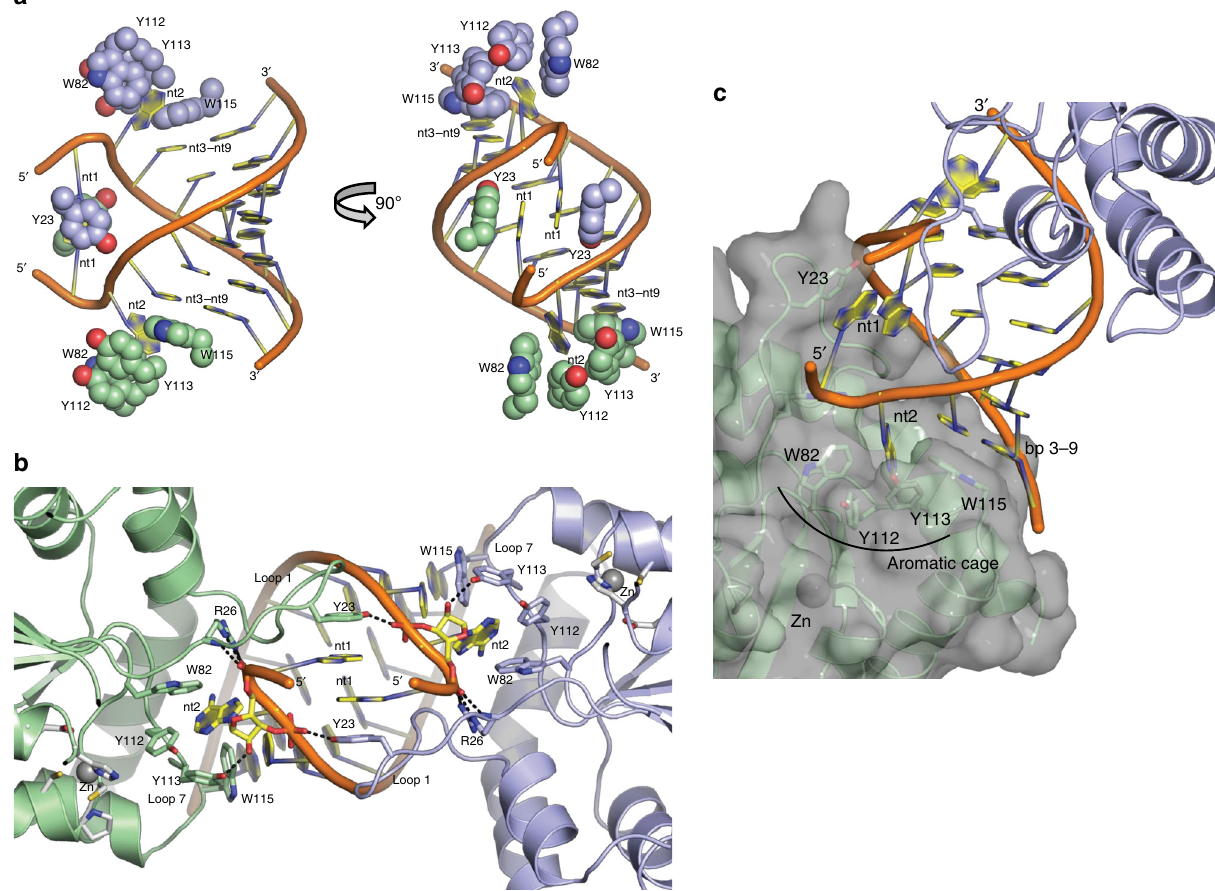
Fig. 4 Unusual A3H – RNA interaction. a Aromatic amino acids (spheres with C colored as in Fig. 2a) that contact RNA bases (cartoon). The nt1 bases stack with each other and with Tyr23, the nt2 bases are bound in an “ aromatic cage ” , and the nt3 – nt9 base pairs stack with Trp115. b Loop 1 protrusion into the RNA narrow major groove. Key amino acids and nucleotides are shown in stick form (green or light blue C, red O, blue N, orange P) with hydrogen bonds (dashed lines) from Tyr23, Arg26, and Tyr113 to the RNA. Side chains in the active sites are shown in stick form with white C atoms and Zn ions as gray spheres and correspond to the zinc-dependent deaminase signature motif (C/H)xE(x) n PCxxC (His54, Glu56, Pro84, Cys85, Cys88). c Surface view of one A3H molecule showing the pocket formed by the “ aromatic cage ” for the unpaired nt2 base and the nearby active site form an A3H – RNA complex, whereas the analogous A3G NTD surface is hydrophobic and forms a protein dimer 22 , strongly suggesting heterogeneity in the ways in which different A3 pro- teins recognize RNA. Overall, the A3H:RNA complex structure presented herein pro- vides an unexpected view of an unusual RNA-binding mode for A3H and illuminates potential mechanisms of antiviral activity.